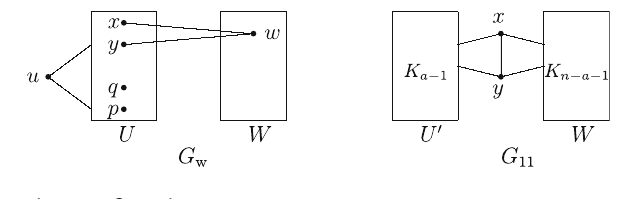
Figure 3: G w and ∈ G φ 11